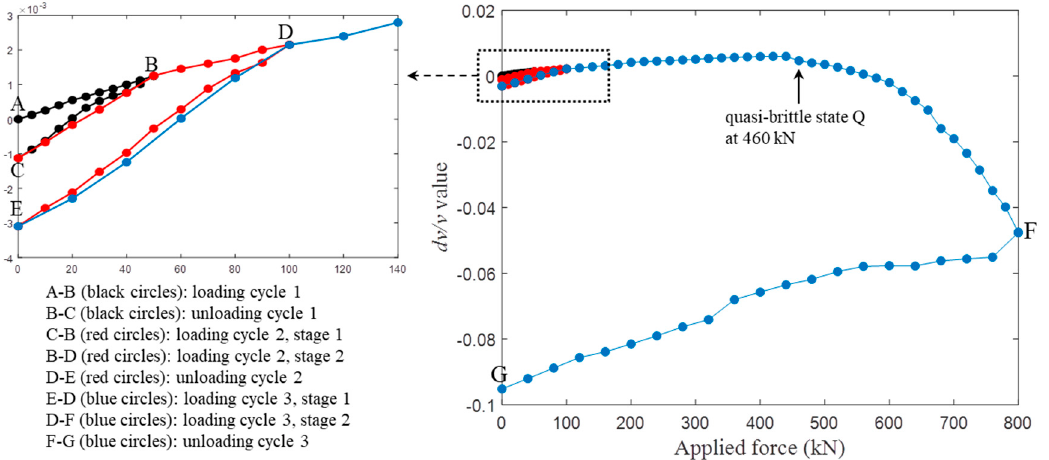
Figure 5. An example of the dv / v calculation values as a function of the applied forces, corresponding to the C30-1 and R1 acquisitions. The characters A-G denote the associated loading steps (see Figure 2).